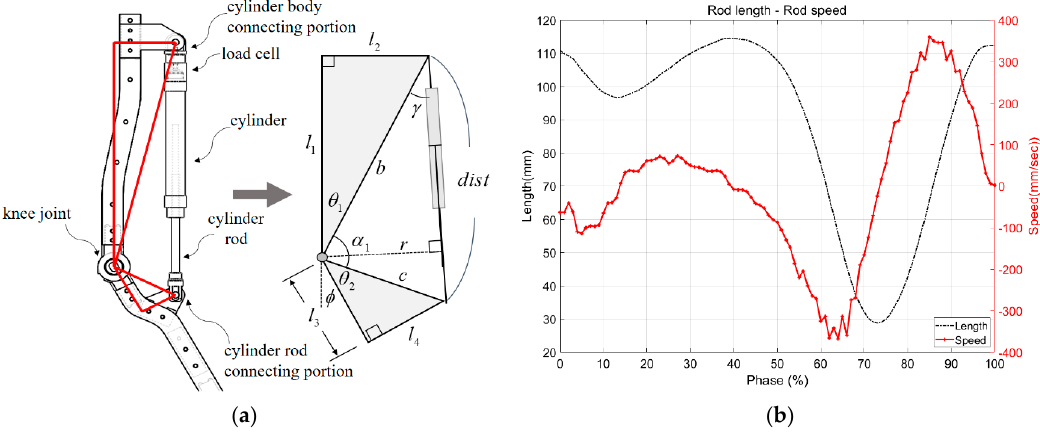
Figure 4. ( a ) This is the knee structure of the exoskeleton robot and its simplification. ( b ) This is the change in length of the cylinder and the speed.